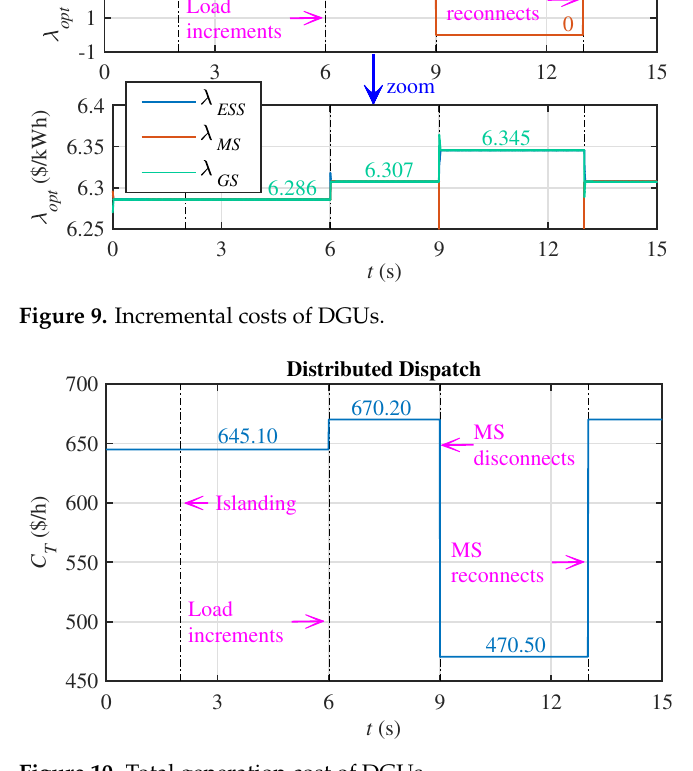
Figure 10. Total generation cost of